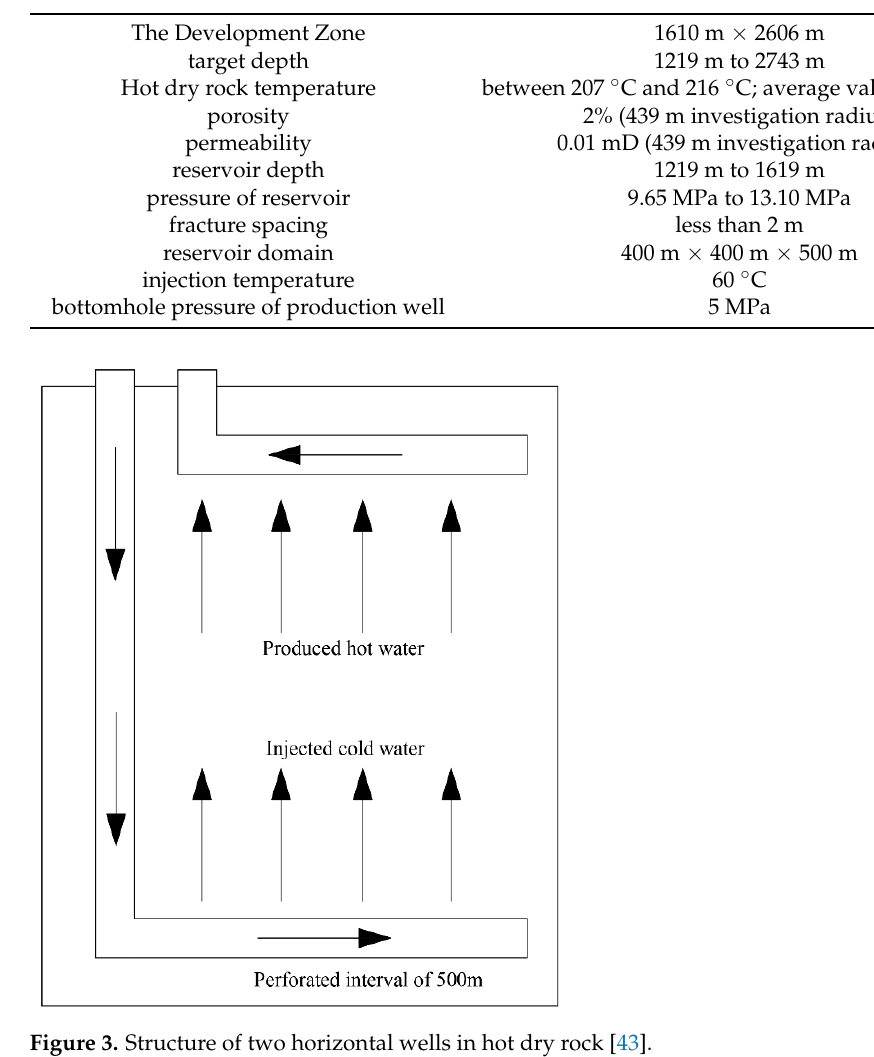
Table 1. The Parameters of the DP32-1 Site [43].